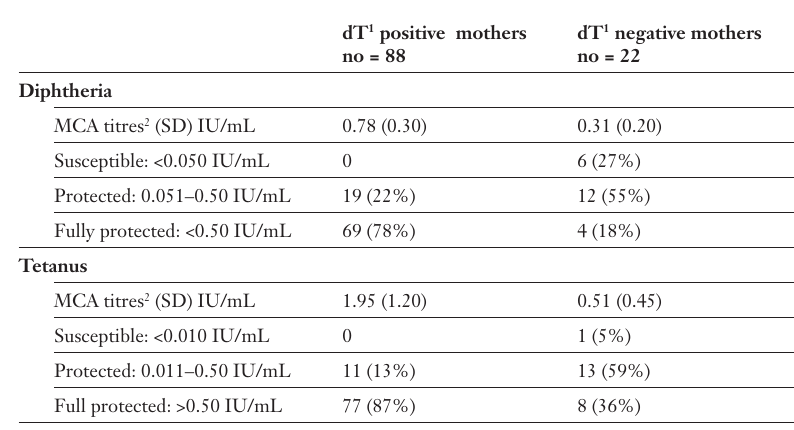
Table 2 Seroimmunity levels and mean concentration of antibody titres against diphtheria and tetanus in in- fants and their rela- tion to their moth- ers’ dT 1 vaccination status, Sari-Iran.